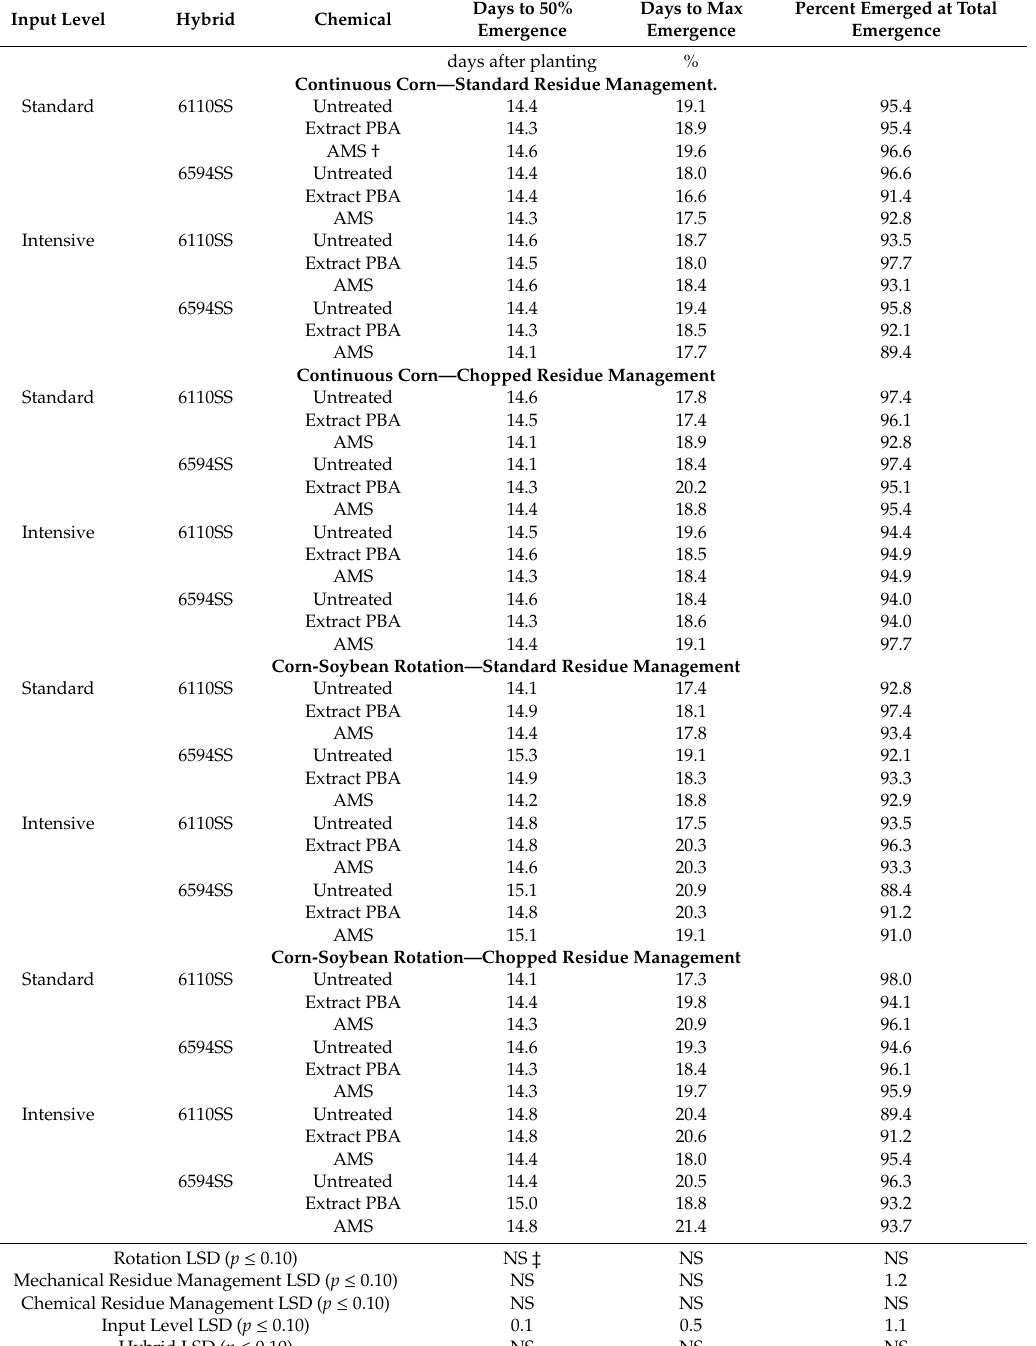
Table 5. Days to 50% and maximum emergence and percentage of total emerged at completion of emergence as influenced by crop rotation, mechanical and chemical residue management, input level, and corn hybrid when grown at Champaign, IL during 2017 and